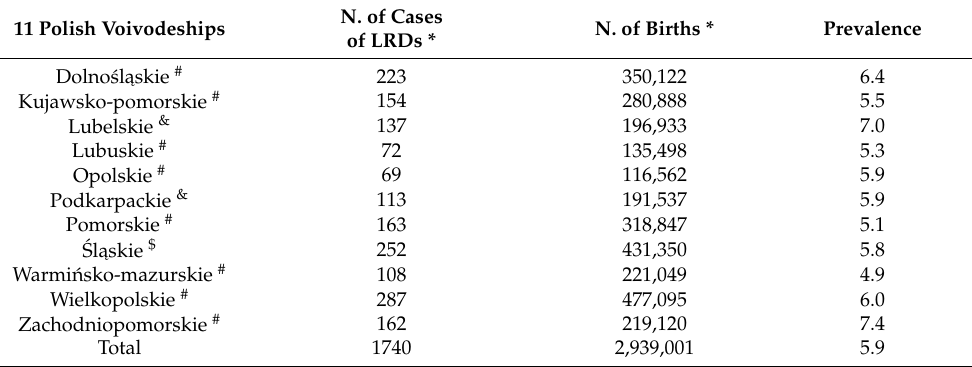
Table 1. The number of cases and prevalence per 10,000 births of limb reduction defects (LRDs) for 11 Polish voivodeships covered by the Polish Registry of Congenital Malformations (PRCM) from 1998 to 2010.